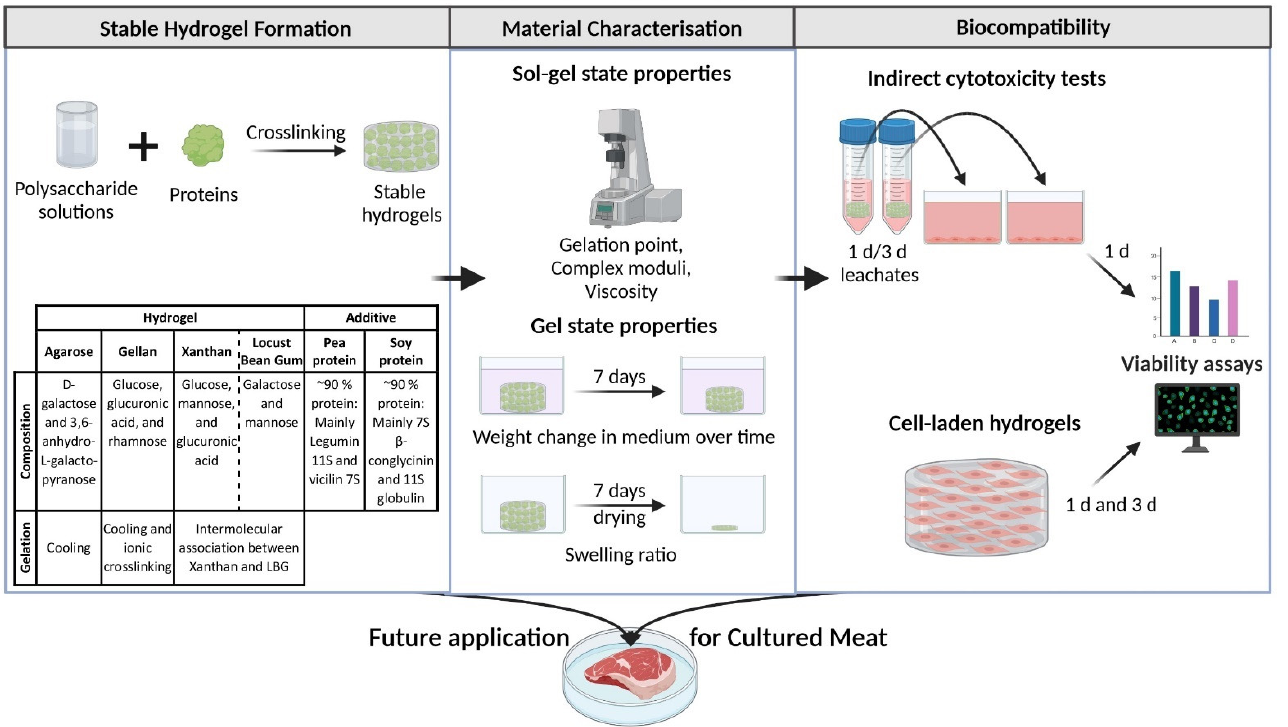
Figure 1. Schematic overview of the biomaterial evaluation in this study, starting with the investigation of stable gel formation of polysaccharide-protein blends and followed by the of stable gel formation of polysaccharide-protein blends and followed by the characterization of the characterization of the material properties and biocompatibility to find suitable biomaterials for a material properties and biocompatibility to find suitable biomaterials for a future application in the future application in the cultured meat sector. This figure was created with BioRender.com, cultured meat sector. This figure was created with BioRender.com, (accessed on 28 December (accessed on 28 December 2021).